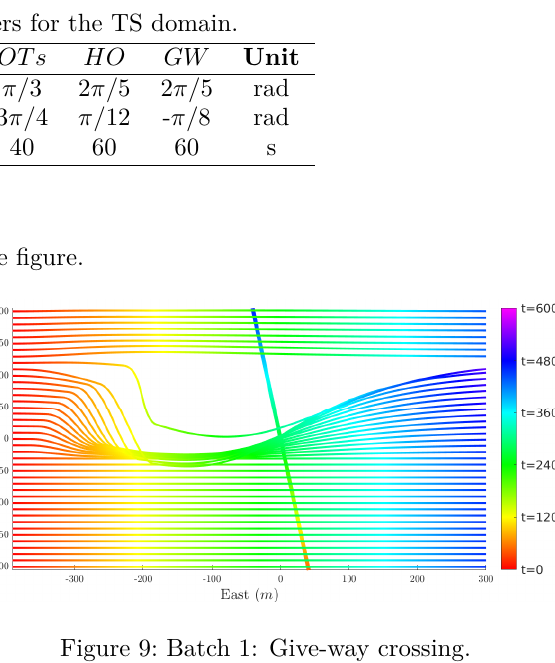
Figure 9: Batch 1: Give-way crossing.